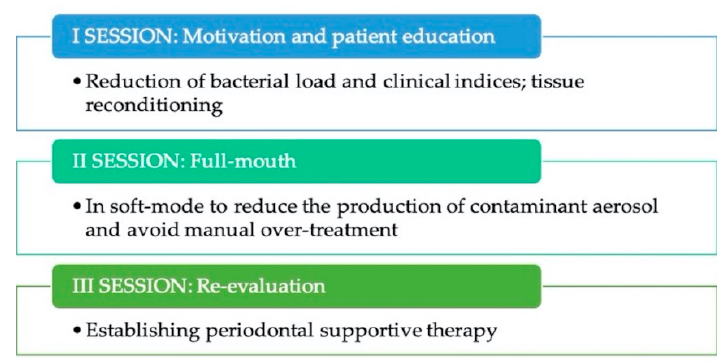
Figure 3. Sessions for modified full mout disinfection protocol.